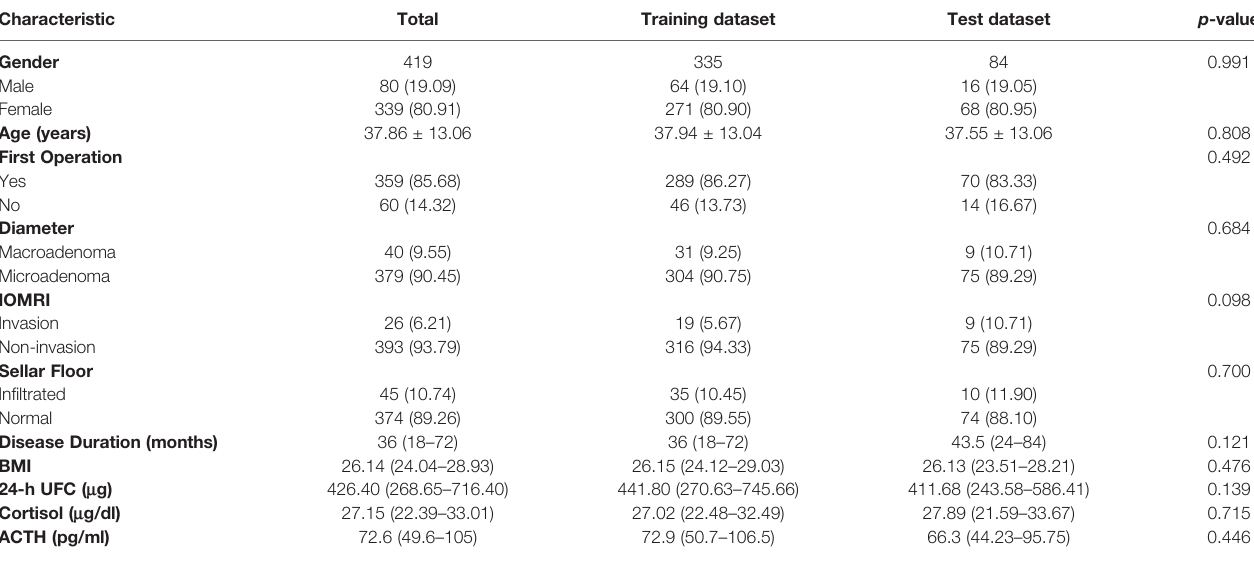
TABLE 1 | Participants ’ characteristics in trainning and test datasets.